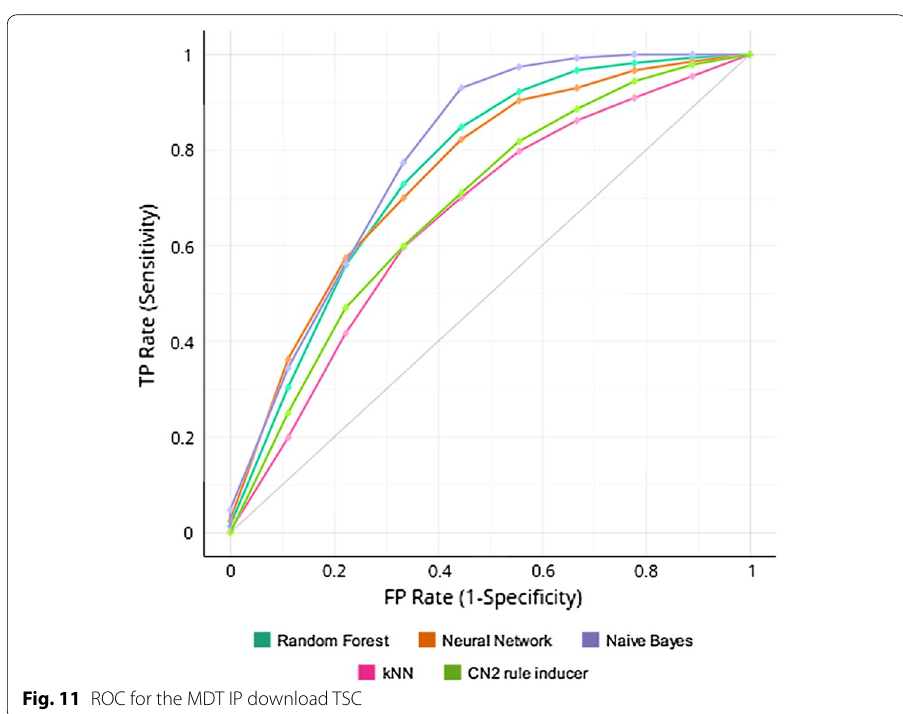
Fig. 11 ROC for the MDT IP download TSC